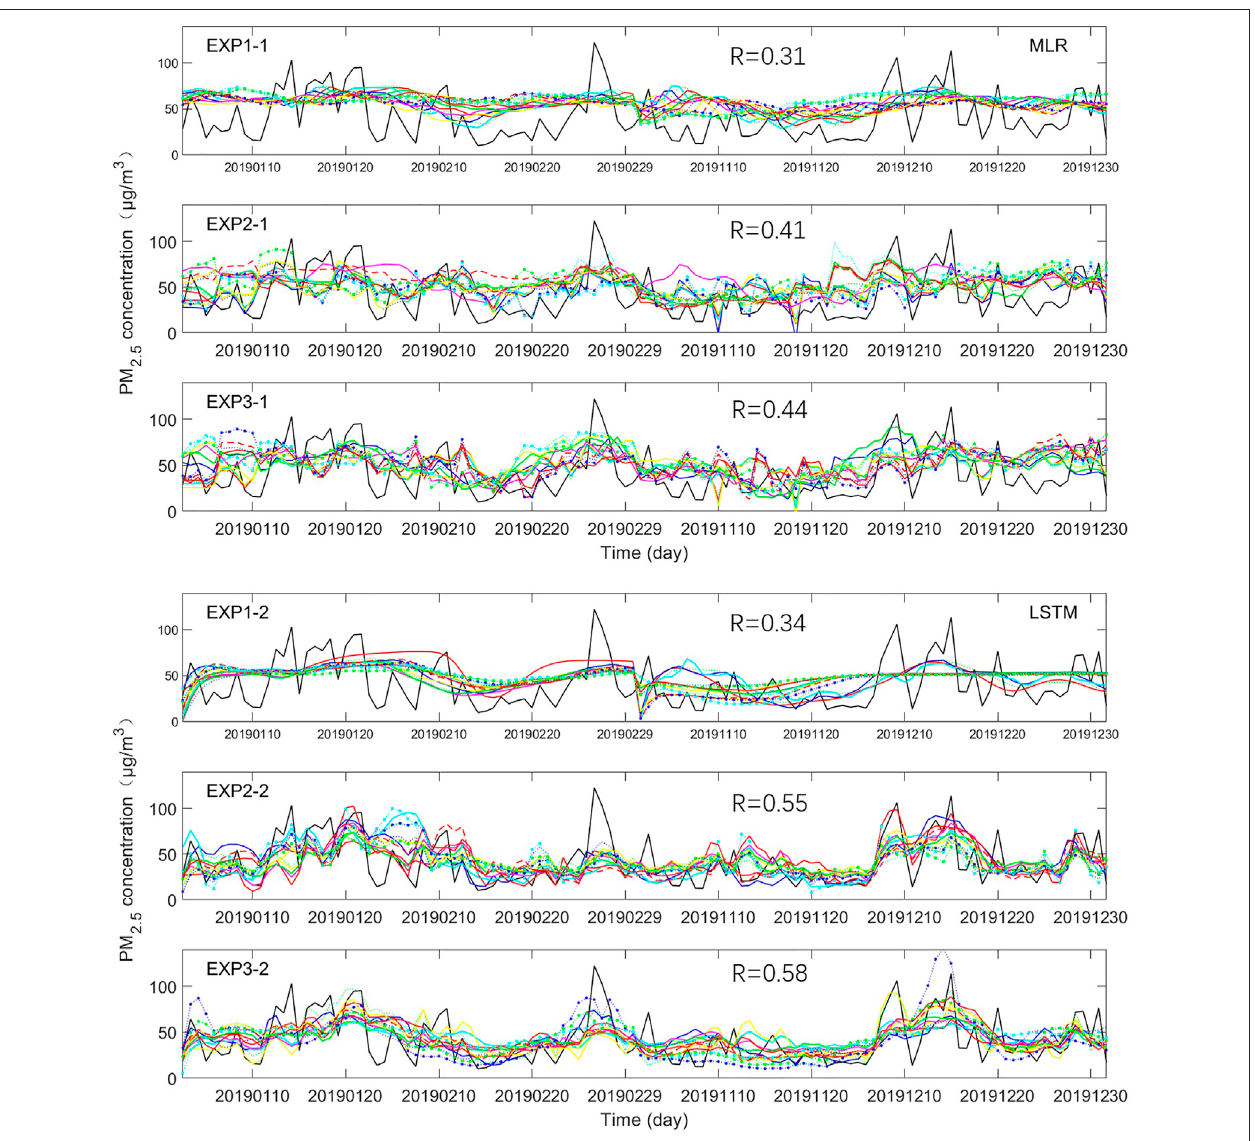
FIGURE7| ComparisonofresultsfromEXP1toEXP3withtheactualconditionfor (A) MLRand (B) LSTMmodel.(Note:TheblacklineisthemeasuredPM 2.5 ,and the colored lines are the daily forecast, R is the correlation coef fi cient of 1- 20-day average prediction with observation.)